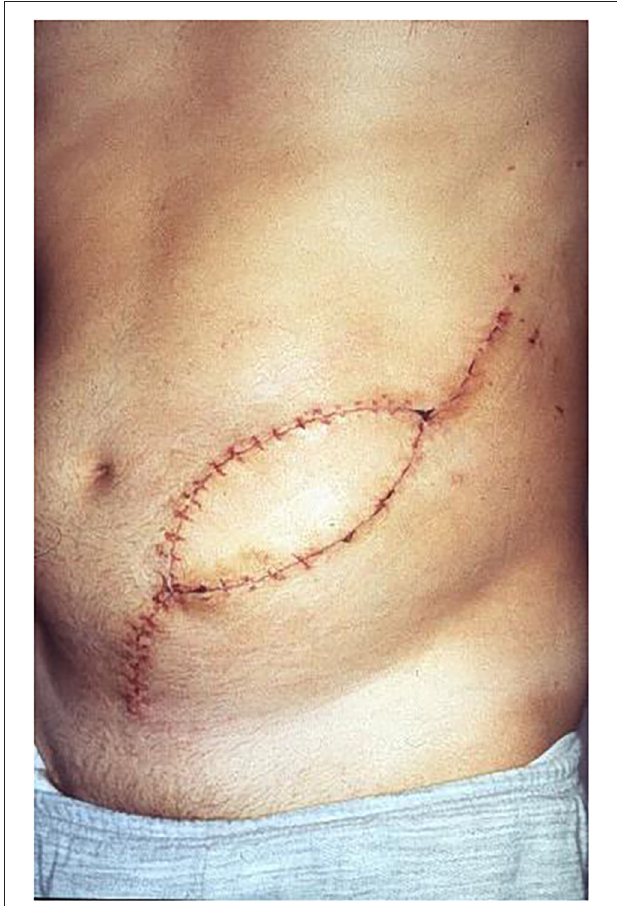
FIGURE 7 | Patient 2 weeks after surgery and stitch removal with fLDM.